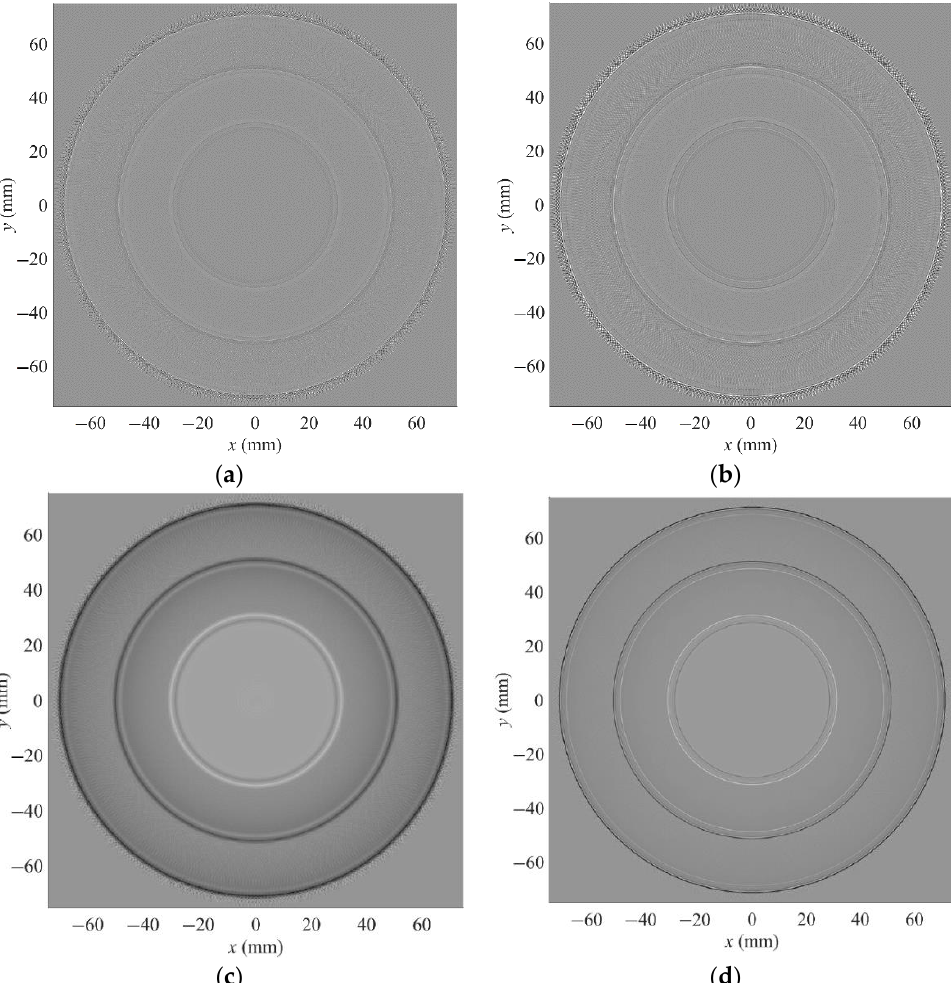
Figure 7. Reconstructing the acoustic source position image with the obtained waveforms based on the following system transfer function: the real-valued Morlet waveform in the case of ( a ) 1 MHz and ( b ) 0.32 MHz; and the imaginary-valued Morlet waveform in the case of ( c ) 1 MHz and ( d ) 0.32 MHz.